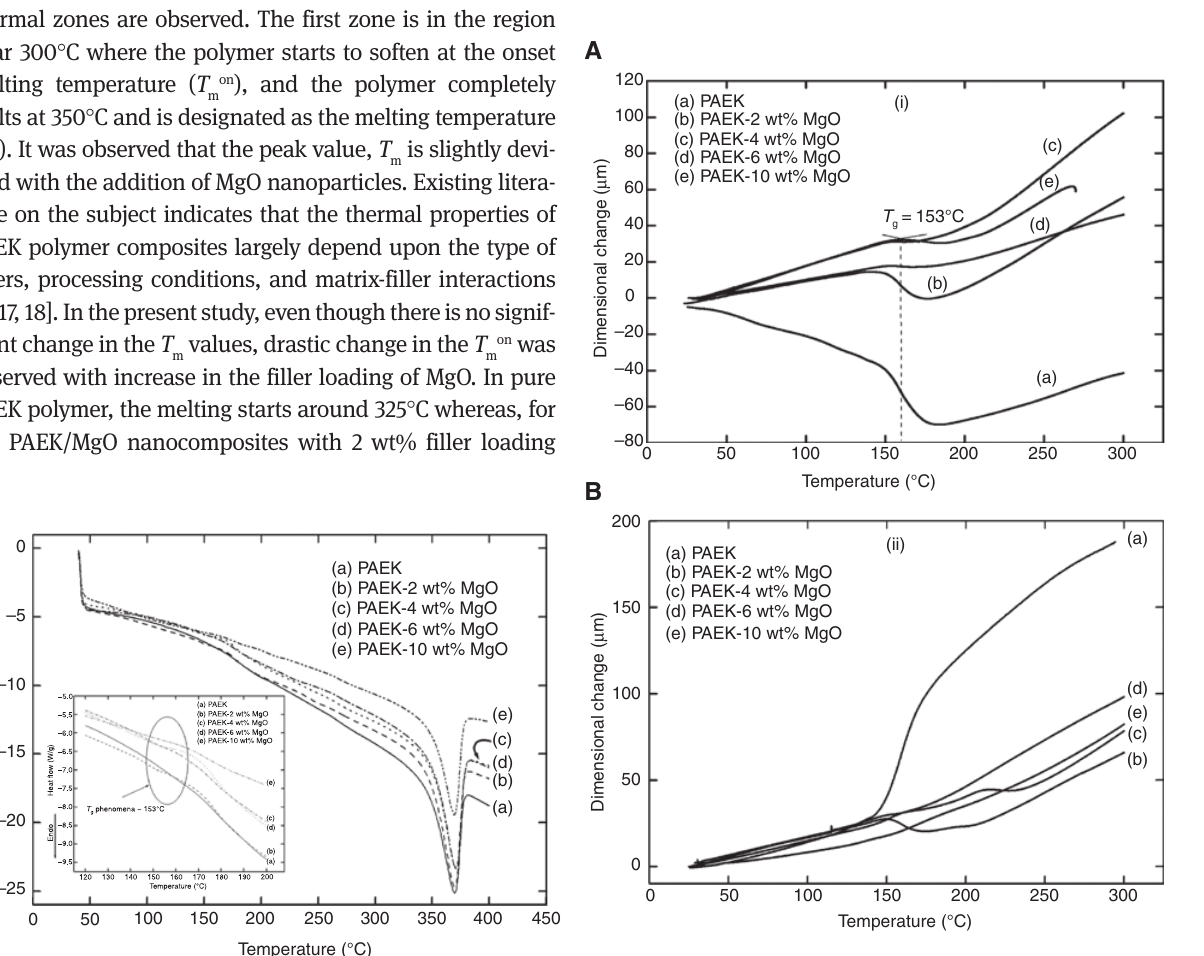
Figure 8: DSC plot of PAEK-MgO nanocomposites.